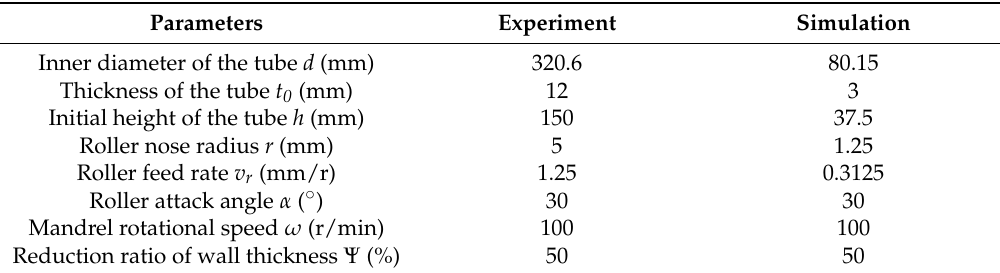
Figure 3. Schematic of area division of the tube in forward spinning. Table 3. Process parameters in simulation and experiment.